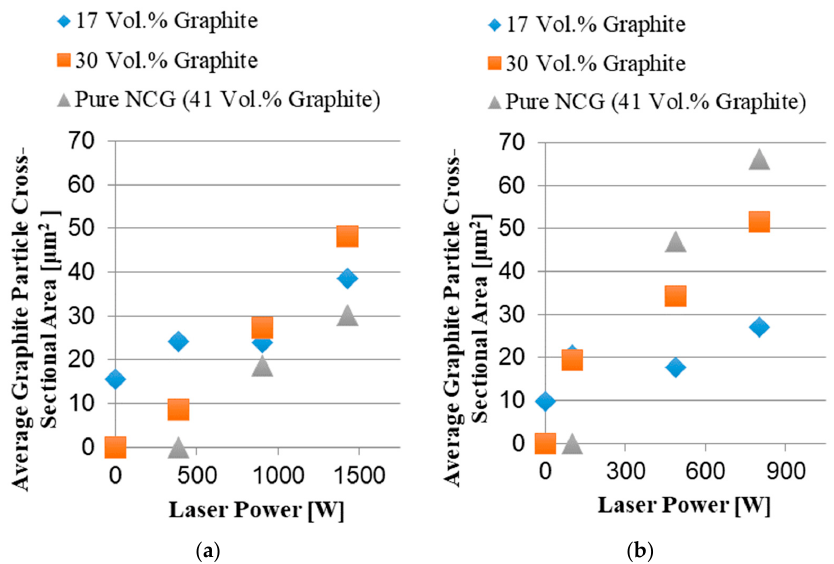
Figure 8. Graphite particle size for single lines deposited on aluminium ( a ) and titanium ( b ). Cross-sections of tracks deposited using feedstocks containing 30 and 41 vol% graph- ite are shown in Figure 9a and Figure 9b, respectively. The graphite flakes visible in the deposits are similar in scale to those seen in the as-received NCG powder, Figure 9c.